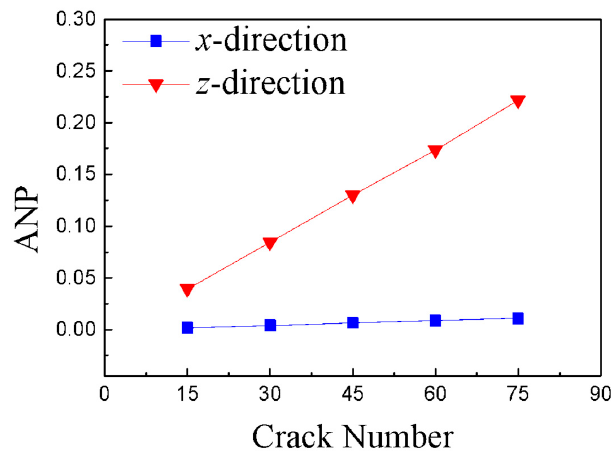
Figure 14. ANP versus crack length ( μ = 0.3). Figure 13. ANP versus crack number ( µ = Figure 13. ANP versus crack number ( μ = 0.3).